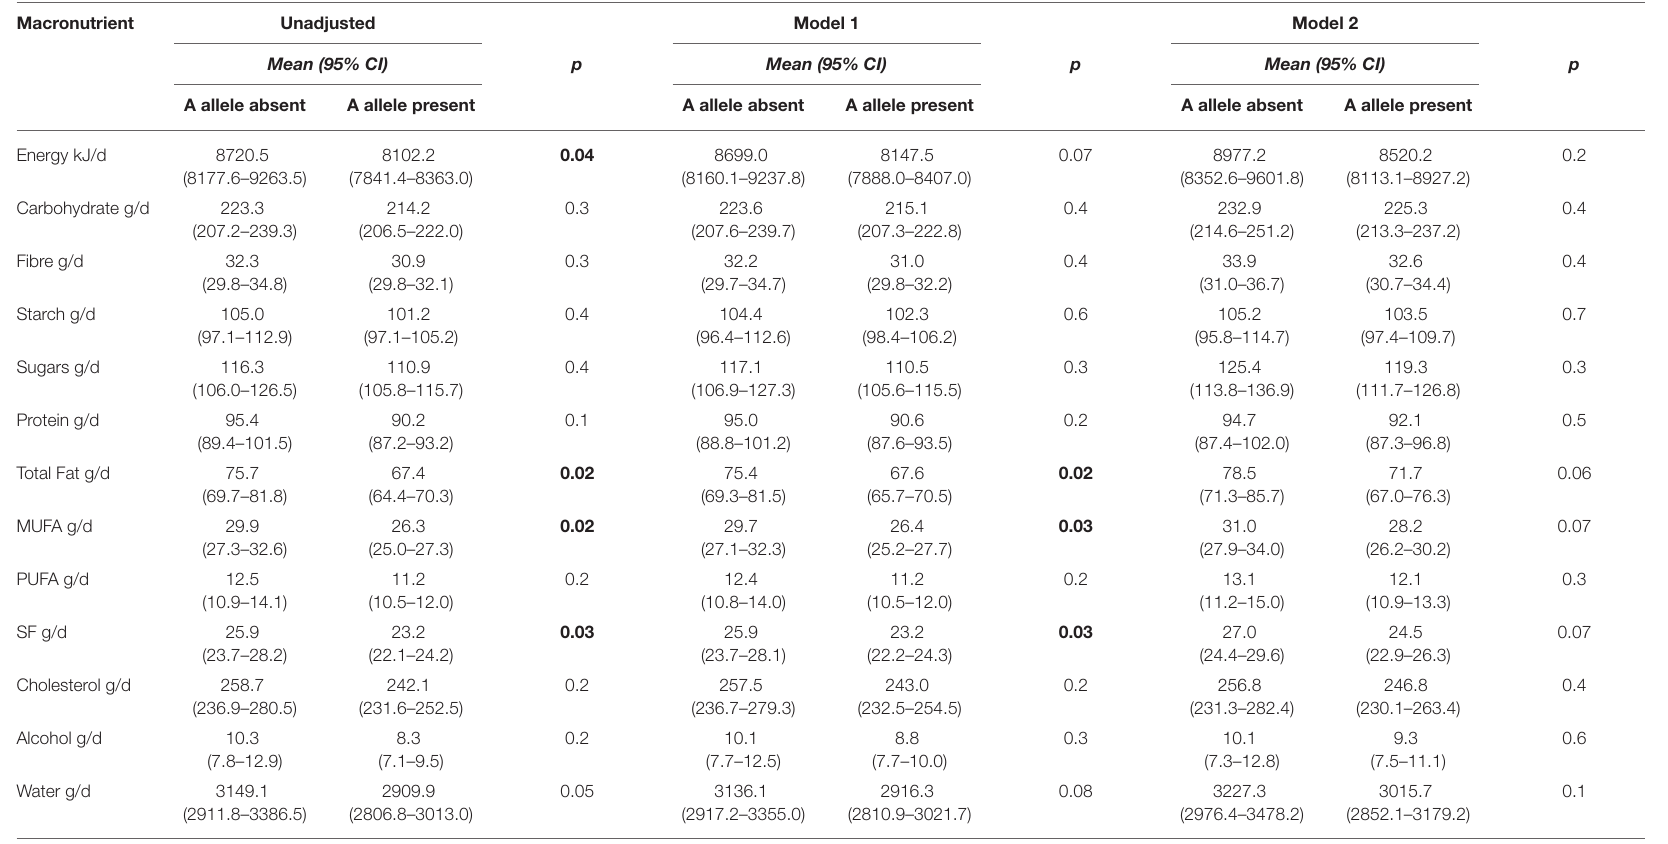
TABLE 1 | Estimated energy and macronutrient intakes vary by the presence of the KCNJ2 -A allele in unadjusted and adjusted